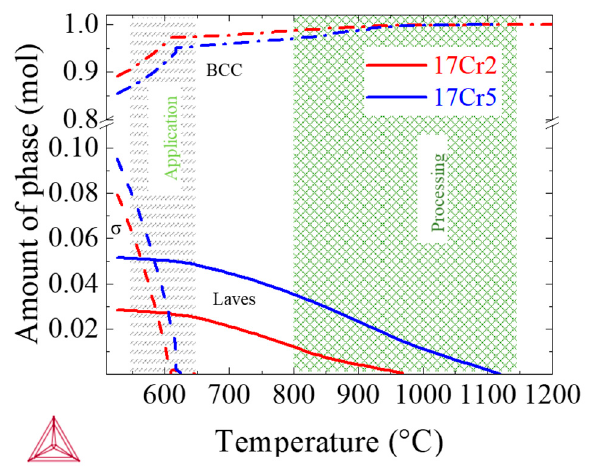
Figure 1. Area fraction of Laves phase in two HiperFer steels (17Cr2:17Cr2.6W0.6Nb0.2Si, 17Cr5:17Cr4W1Nb0.2Si).